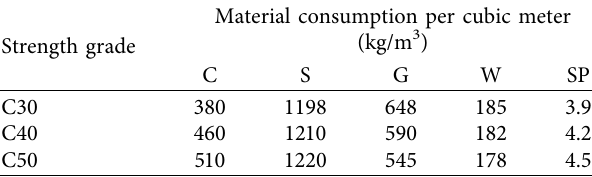
Table 3: Properties of concrete. Table 4: Concrete material consumption